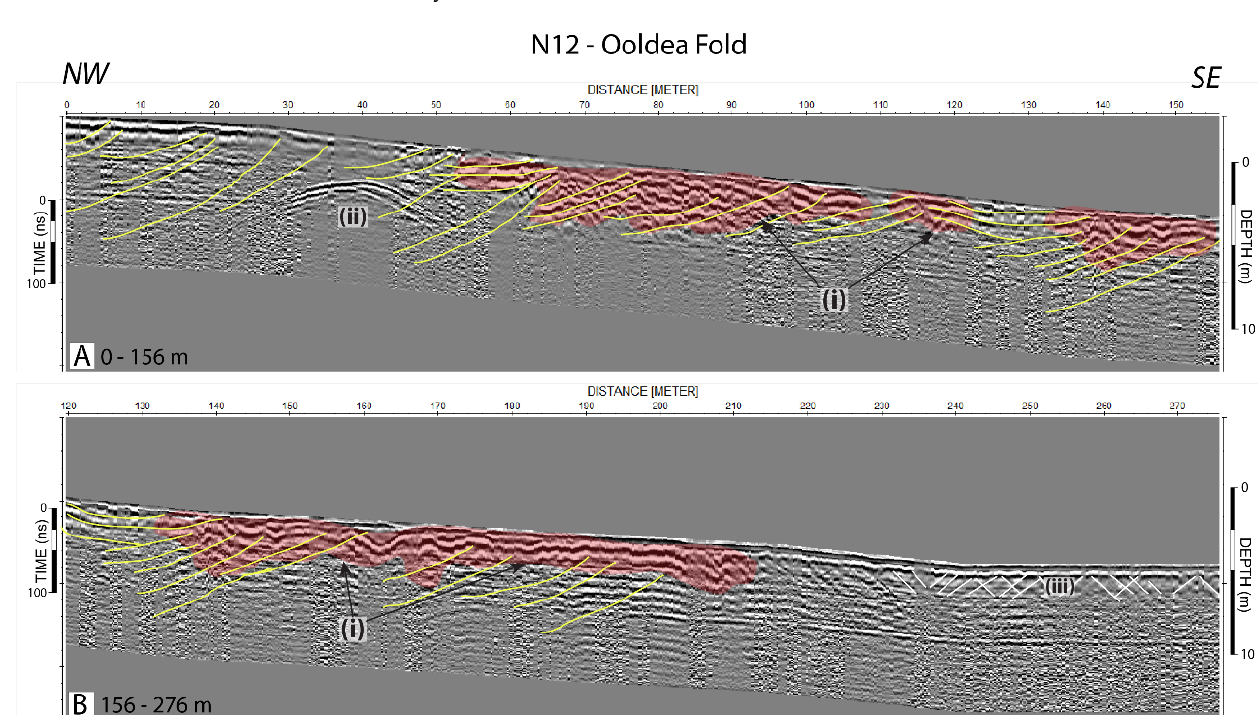
Figure 15. ( A , B ): GPR transect N12, interpreted reflectors shown in yellow; (i): zones of strong reflector packages underneath the scarp slope (in red); ( ii ): airwave reflection from trees.